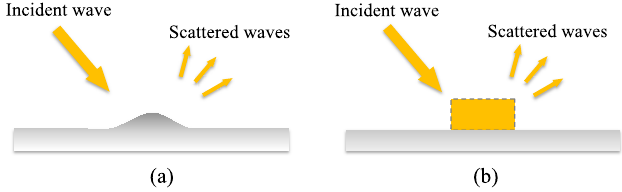
Fig. 2. Bump illusion. (a) Scattered waves by a bump to be mimicked.(b)Scatteredwavesbyanillusionmediumona fl atsurface.